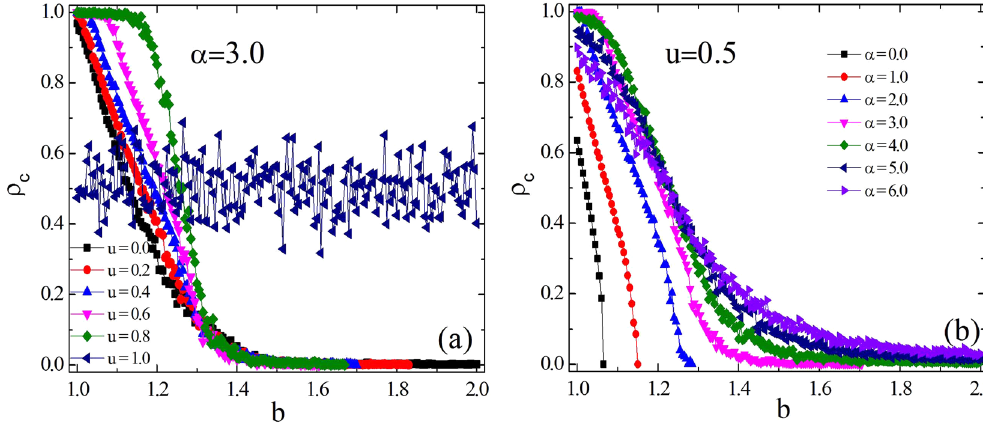
Figure 1. The fraction of cooperation ρ c in dependence on the temptation to defect b . Panels (a) and (b) represent the conditions of changing the parameter u for α = 3.0 and regulating the parameter α for u = 0.5, respectively. All the results are obtained for L × L = 10 4 nodes, k = 4 and K =